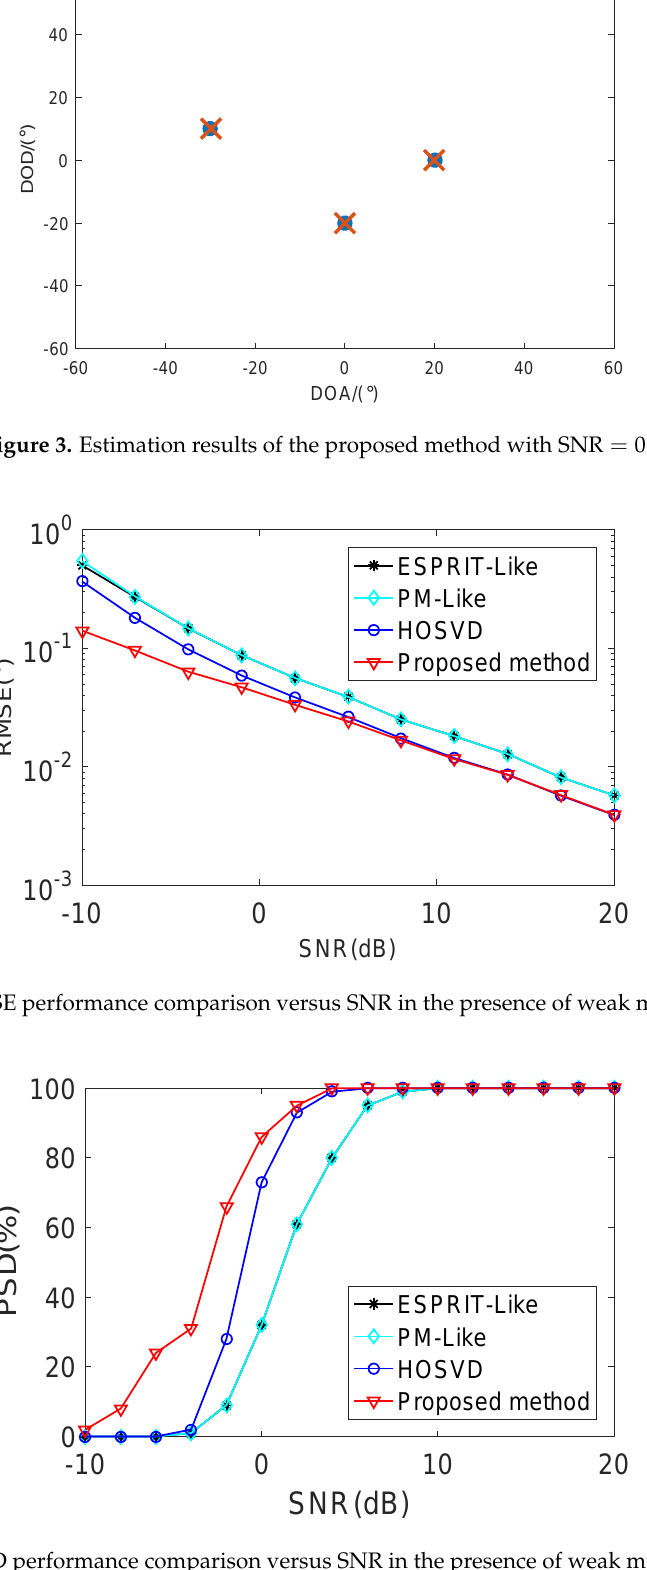
Figure 5. PSD performance comparison versus SNR in the presence of weak mutual